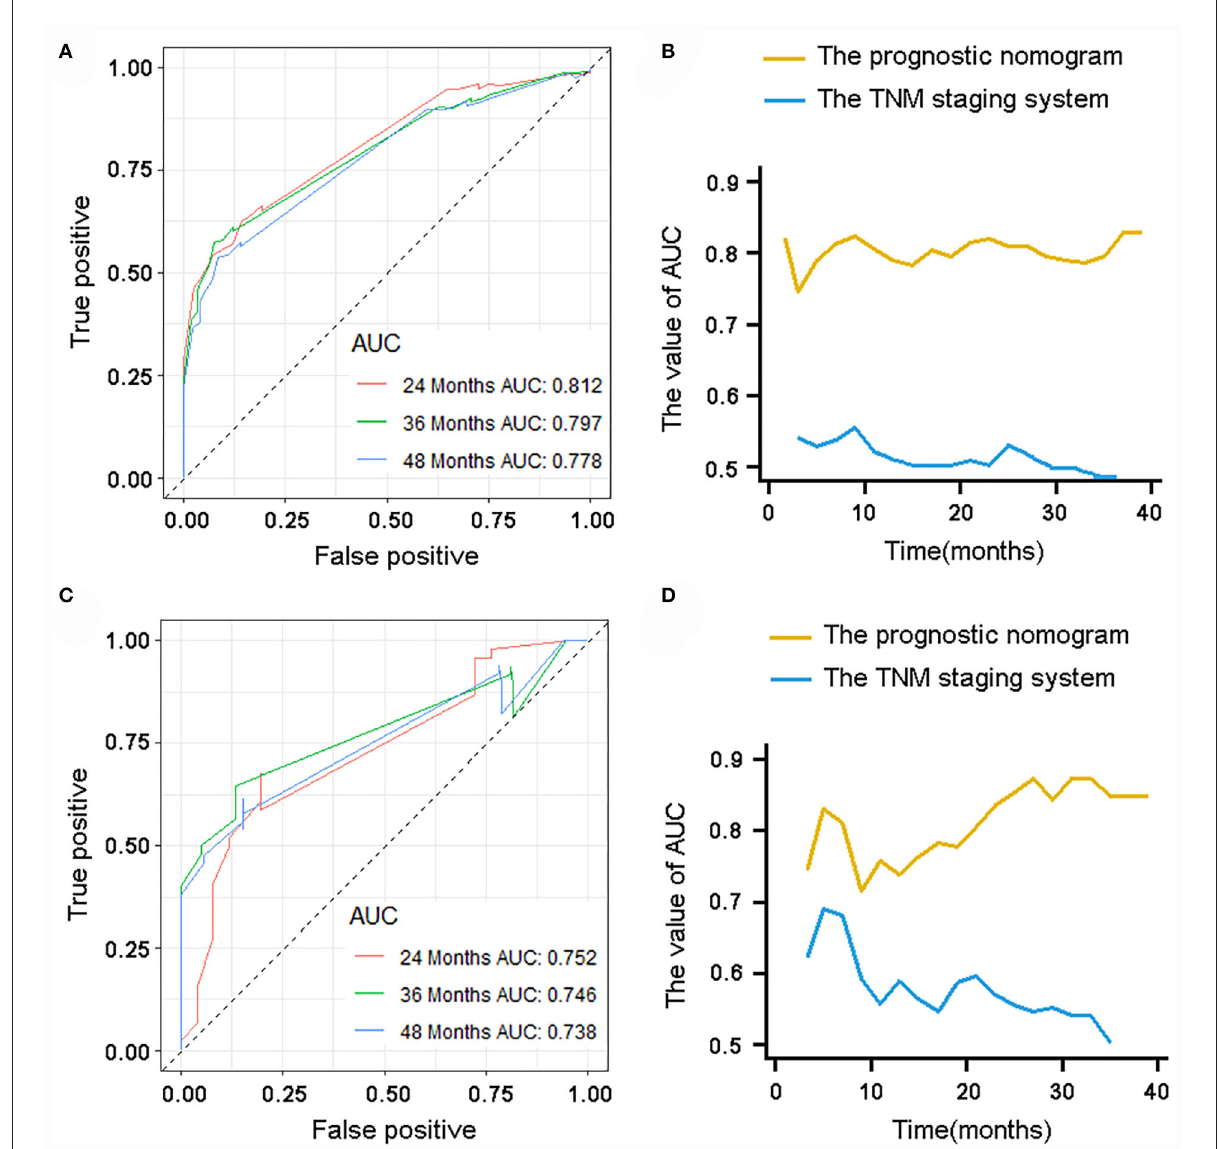
FIGURE9 ROC curve analysis of the nomogram for 24, 36, and 48 months in the training set (A) and the validation set (C) . Time-dependent ROC curves for comparison of the discriminative ability between the nomogram and TNM staging system in the training set (B) and validation set (D) .